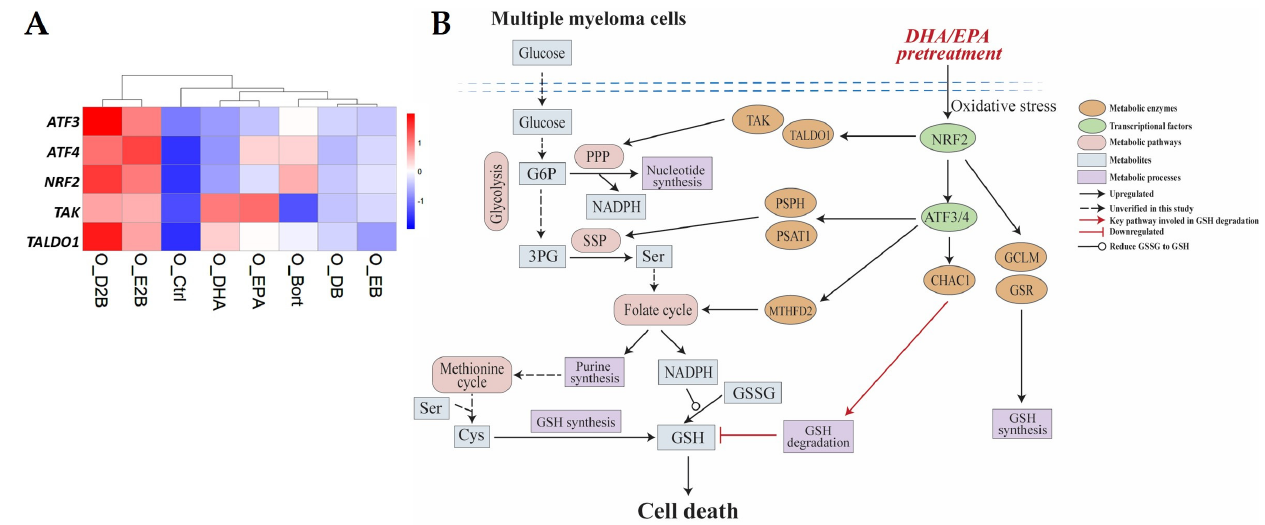
Figure 6. CHAC1-mediated GSH depletion may be important for bortezomib chemosensitivity in MM cells increased by DHA/EPA pretreatment. ( A ) Heatmap analysis of the expression of ATF3 , ATF4 , NRF2 , TAK , and TALDO1 in different conditions. ( B ) Summarizing scheme. Pretreating MM cells with DHA/EPA before bortezomib induces GSH degradation through activating the NRF2-ATF3/4-CHAC1 pathway, which eventually leads to cell death. Meanwhile, metabolic pathways of PPP, SSP, folate cycle, and methionine cycle may be activated to increase GSH synthesis to recover the cellular redox homeostasis during cell death.